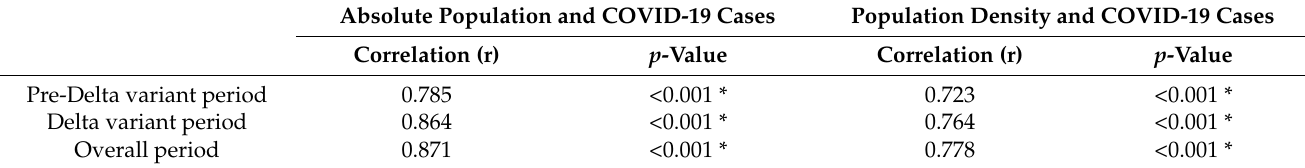
Table 2. Correlation analysis in relation to Delta variant during the third wave in